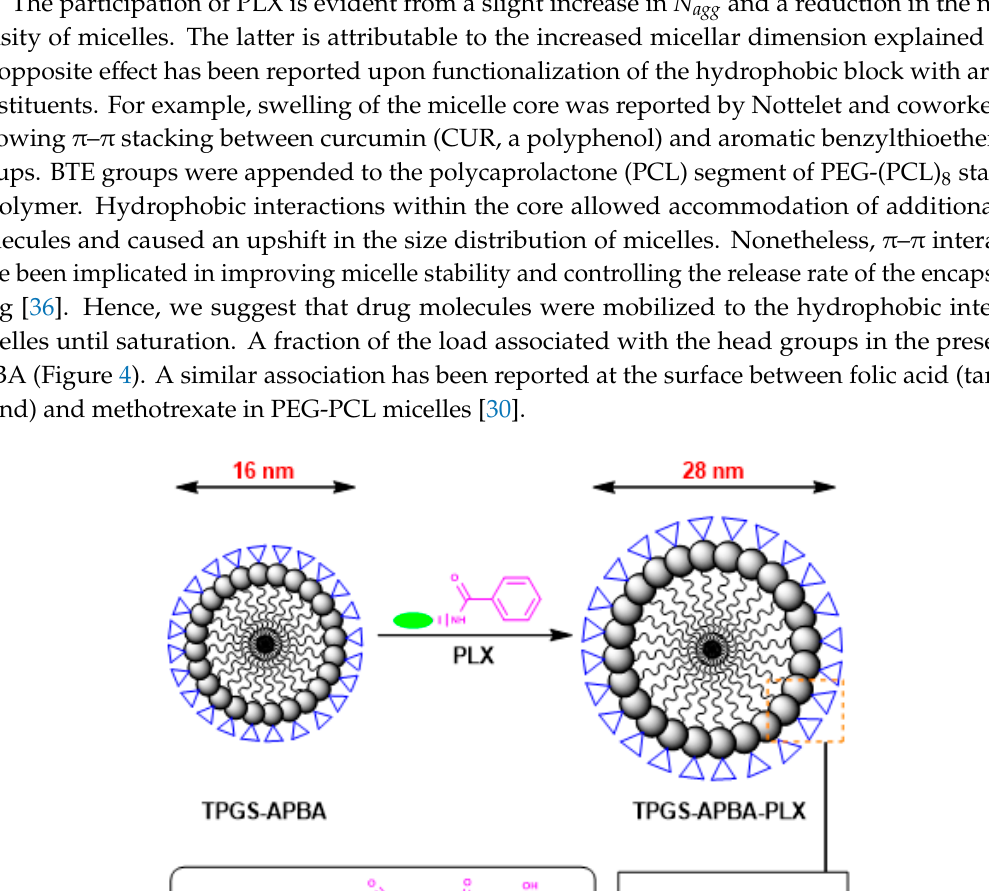
Figure 3. SANS profile showing the effect concentration ( A ), temperature ( B ) and PLX incorporation ( C ) in TPGS-APBA micelles. Bottom panel shows changes in the structure ( D ) and form ( E ) factors of